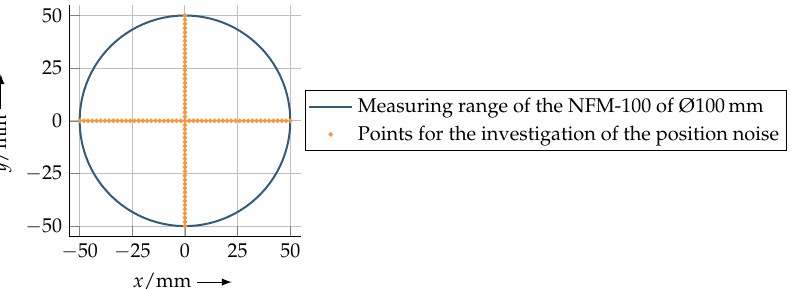
Figure 7. Investigated points for positioning noise over a range of 100mm in x and y direction with a distance of